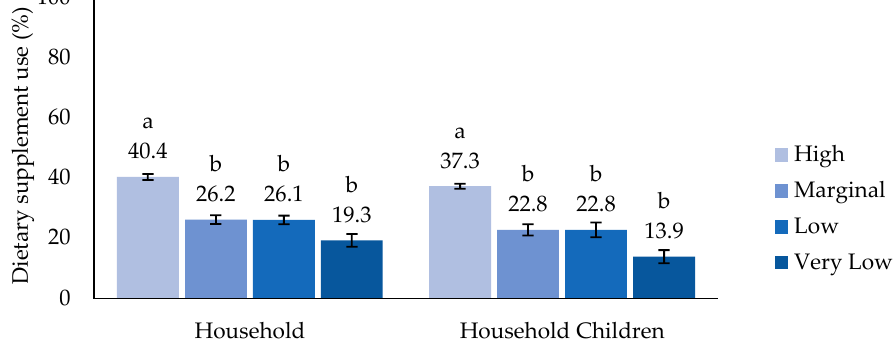
Figure 2. Prevalence of dietary-supplement use among U.S. children (2–17 years) by household food security and food security among household children. Estimates with different alphabet letters are significantly different based on pairwise t-tests within each classification at p -value < 0.05. Percentages may not sum to 100 owing to missing data and/or rounding.